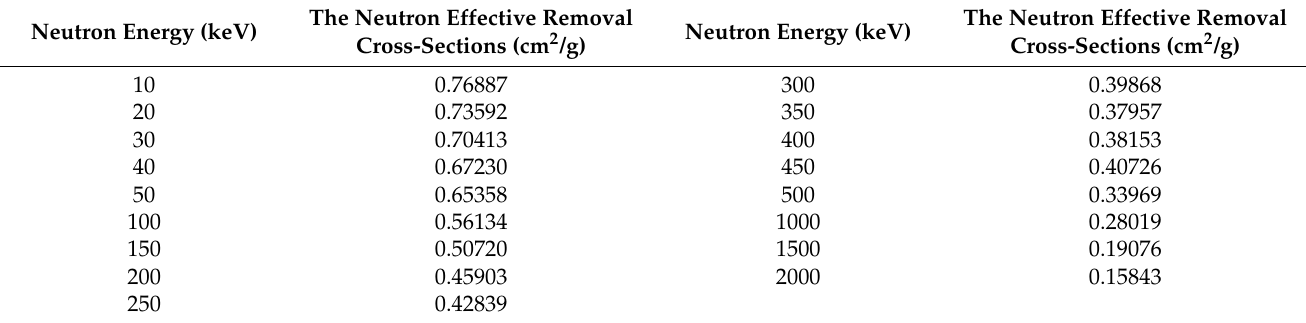
Table 4. The neutron effective removal cross-sections of Polyimide in the investigated energy range as found using